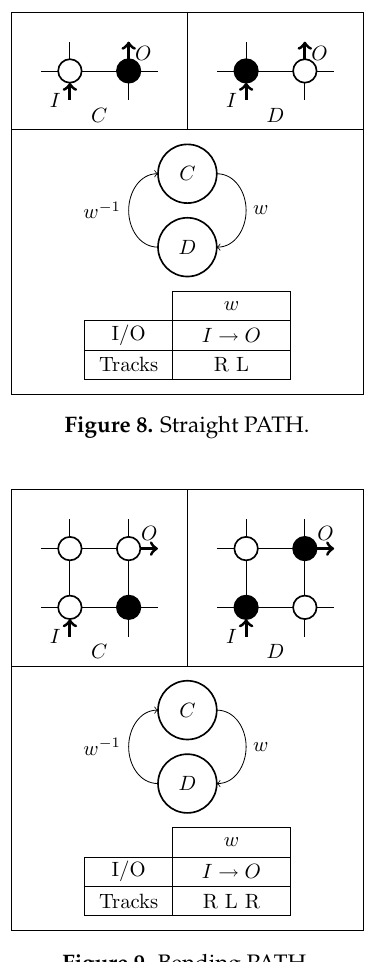
Figure 9. Bending PATH.